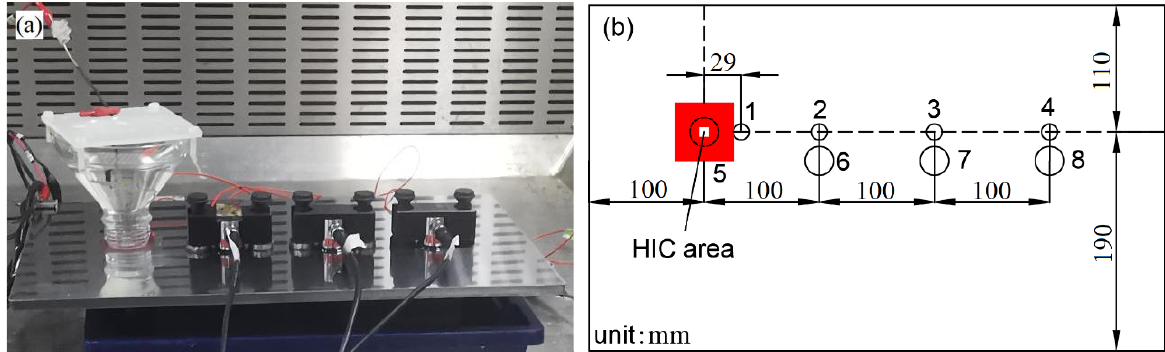
Figure 2. Experimental setup: ( a ) the location of sensors; ( b ) sensor positions. Nano30 locations are shown at 1 to 4, VSI50-RIC at 5 to 8.